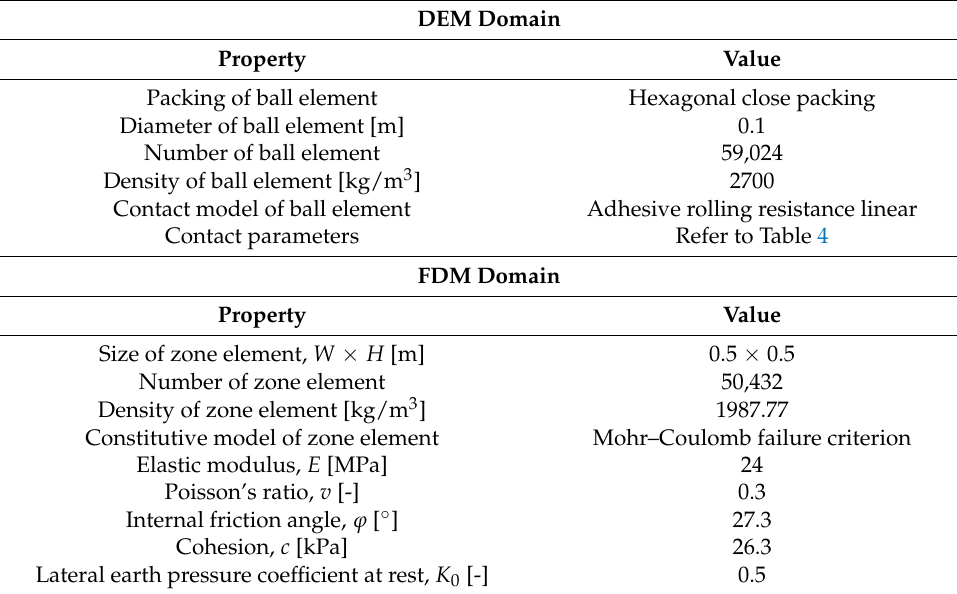
Table 5. Summary of input parameters for ground formation.